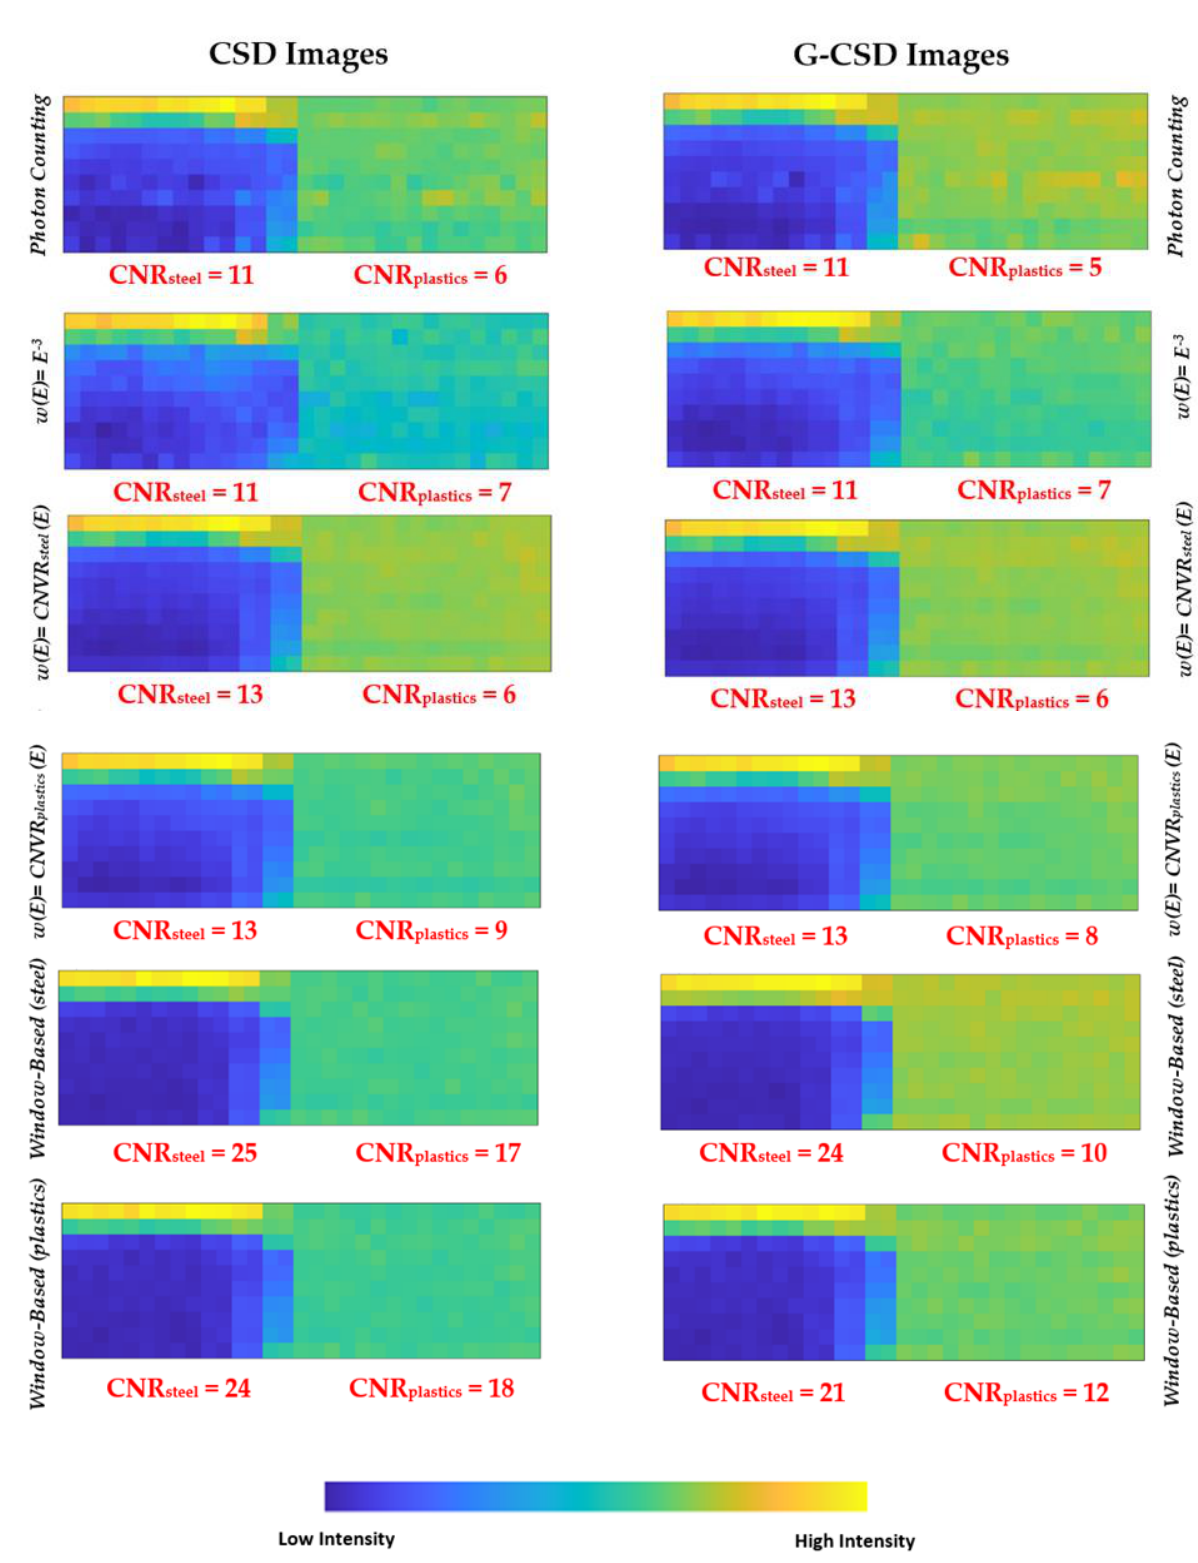
Figure 18. The images and the CNR values (steel and plastics contaminants on coffee) presented in photon counting (PC) mode and after the application of different energy-resolved approaches. The CSD and G-CSD images on the left and right sides, respectively. Generally, two images are obtained, one optimized for steel and the other for plastics detection.